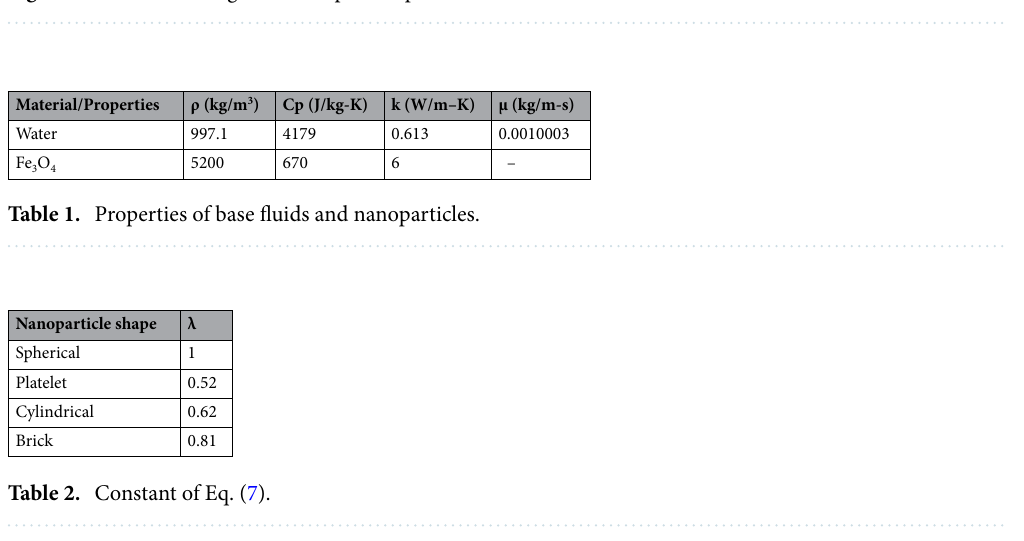
Figure 1. Schematic diagram of the present problem.